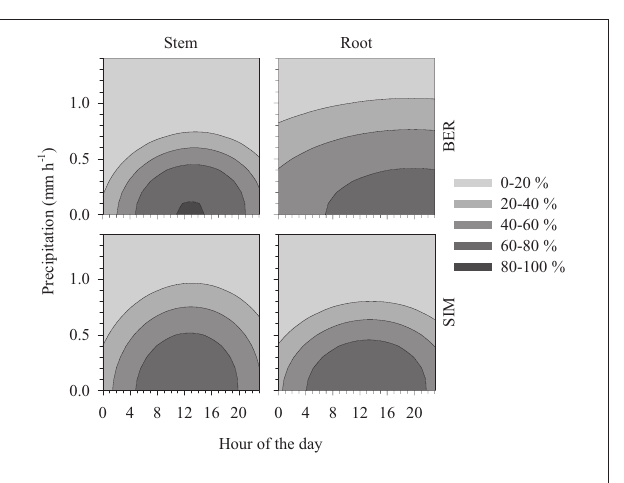
Figure 6 | Bivariate posterior probabilities for classifying a radius variation as contraction estimated by discriminant analyses performed between the hour of the day (legal time) and the amount of precipitation in two black spruce stands of the boreal forest of Quebec,